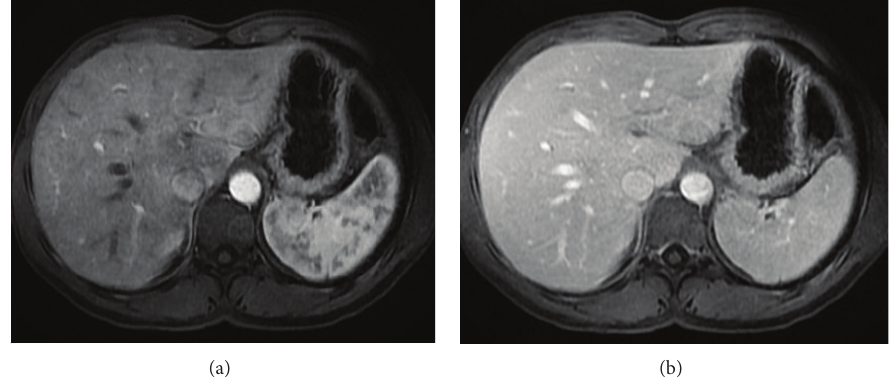
Figure 2: Pattern of enhancement of the normal spleen. Postcontrast axial T1wi 3D-GRE with fat suppression in the arterial (a) and venous (b) phase. The spleen shows a heterogeneous pattern enhancement immediately after contrast material administration (a), secondary to differences in flow between the red and white pulps, becoming homogeneous in venous (b) and interstitial